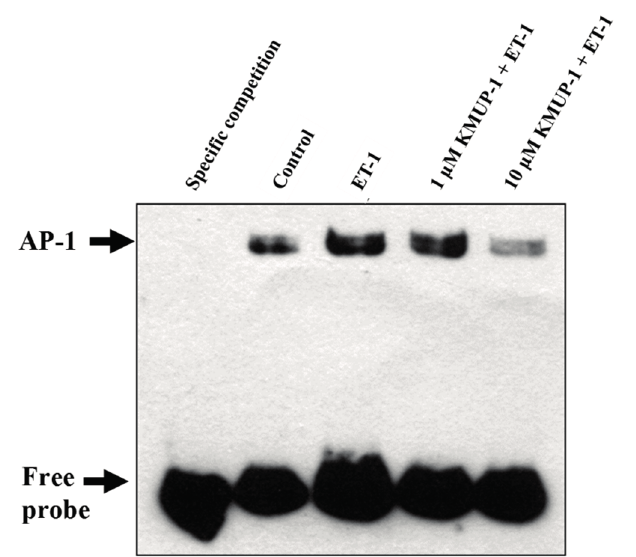
Figure 8. Effects of KMUP-1 on ET-1-induced AP-1 DNA binding activity. H9c2